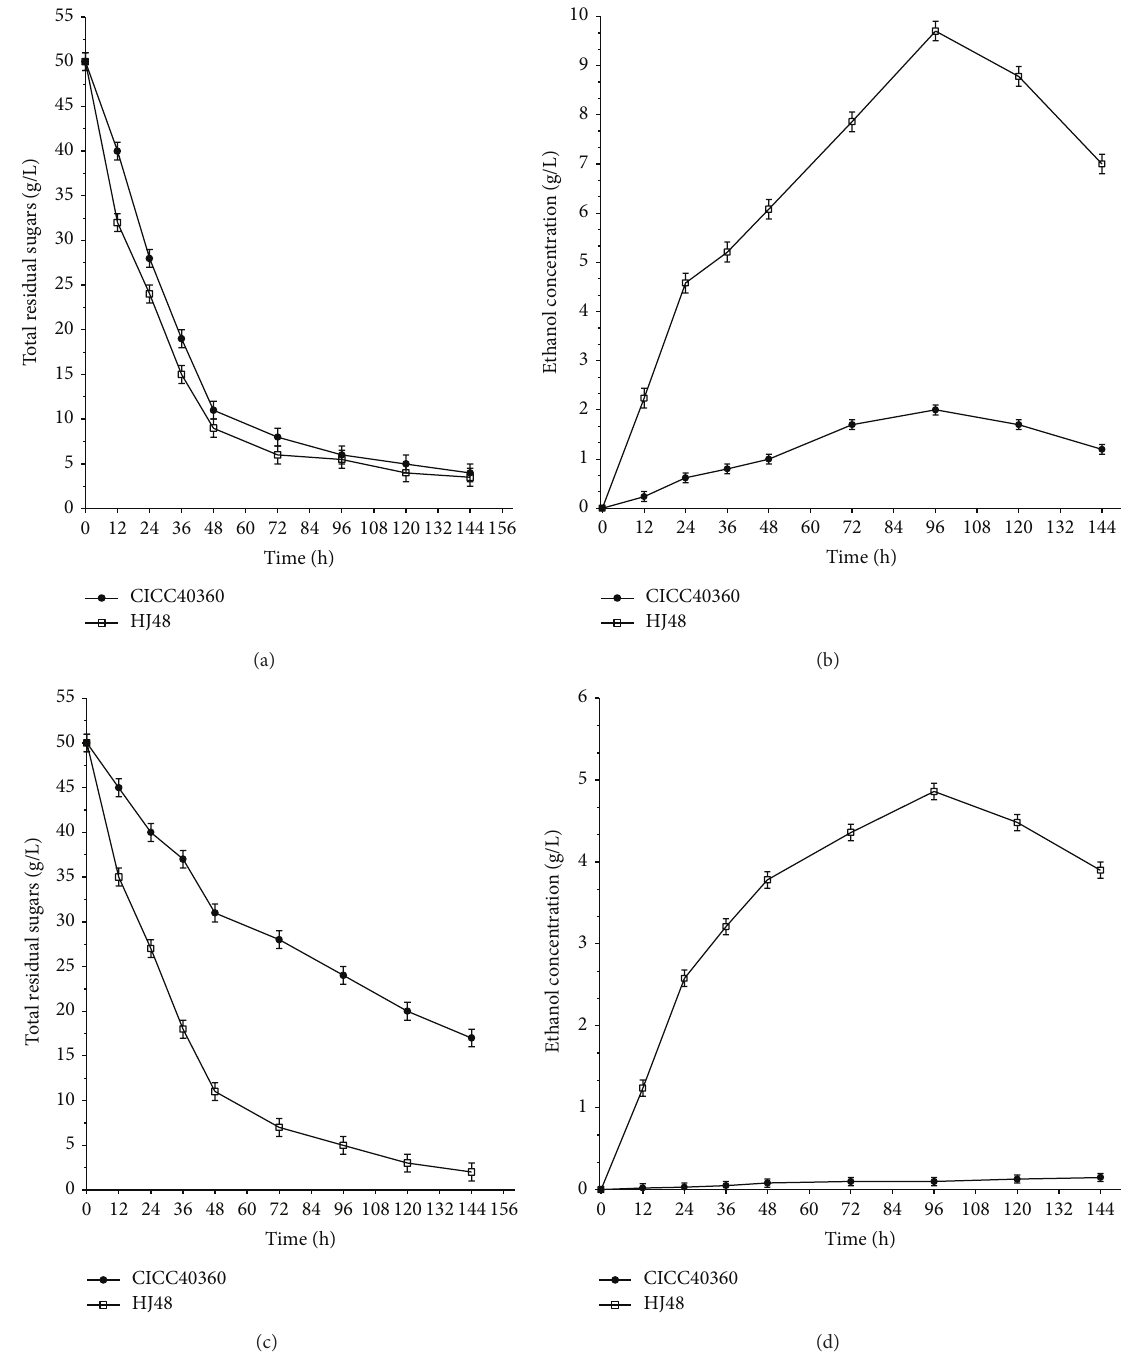
Figure 3: Time courses of glucose consumption and ethanol production by HJ48 and CICC40360 under aerobic conditions (a) and (b) and anaerobic conditions (c) and